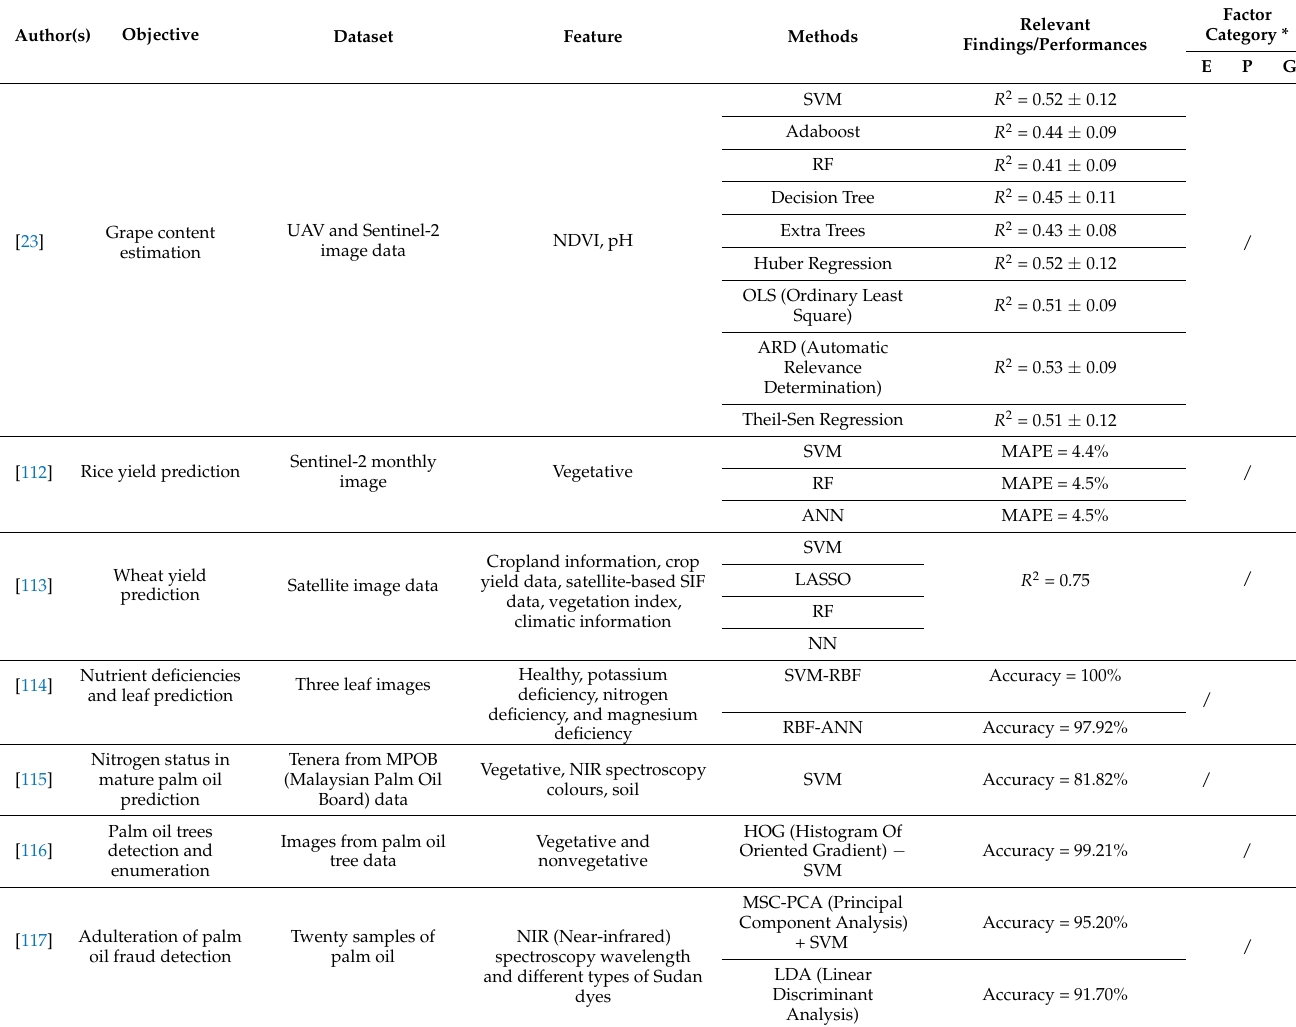
Table 5. SVM prediction of crops and palm